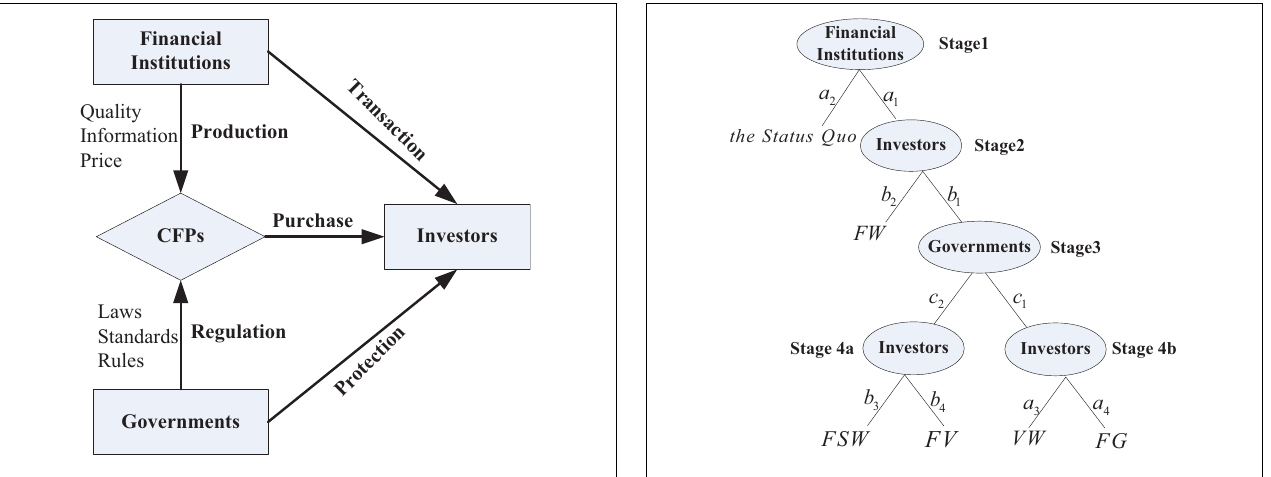
participants: “the challenger”—financial institutions, “the protectors”—investors, and “the